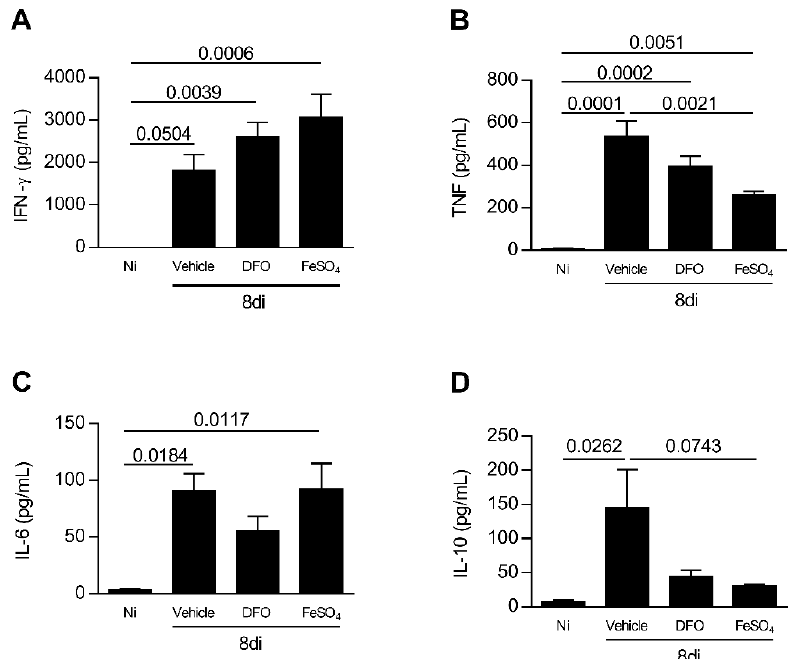
Figure 6. Systemic cytokine profile of T. gondii -infected mice treated with an iron chelator or iron supplemented. C57BL / 6 mice were orally infected with 20 T. gondii ME-49 cysts and treated with vehicle (PBS) or 300 mg / kg deferoxamine (DFO) or 100 mg / kg of ferrous sulfate heptahydrate (FeSO 4 ) intraperitoneally (i.p.) one day before infection and for an additional seven days after infection. The levels of IFN- γ ( A ), TNF ( B ), IL-6 ( C ), and IL-10 ( D ) were measured by the CBA method (Cytometric bead array). Data were analyzed by one-way ANOVA followed by Sidak’s post-test ( A – D ) and Kruskal Wallis followed by Dunn’s post-test ( E ).